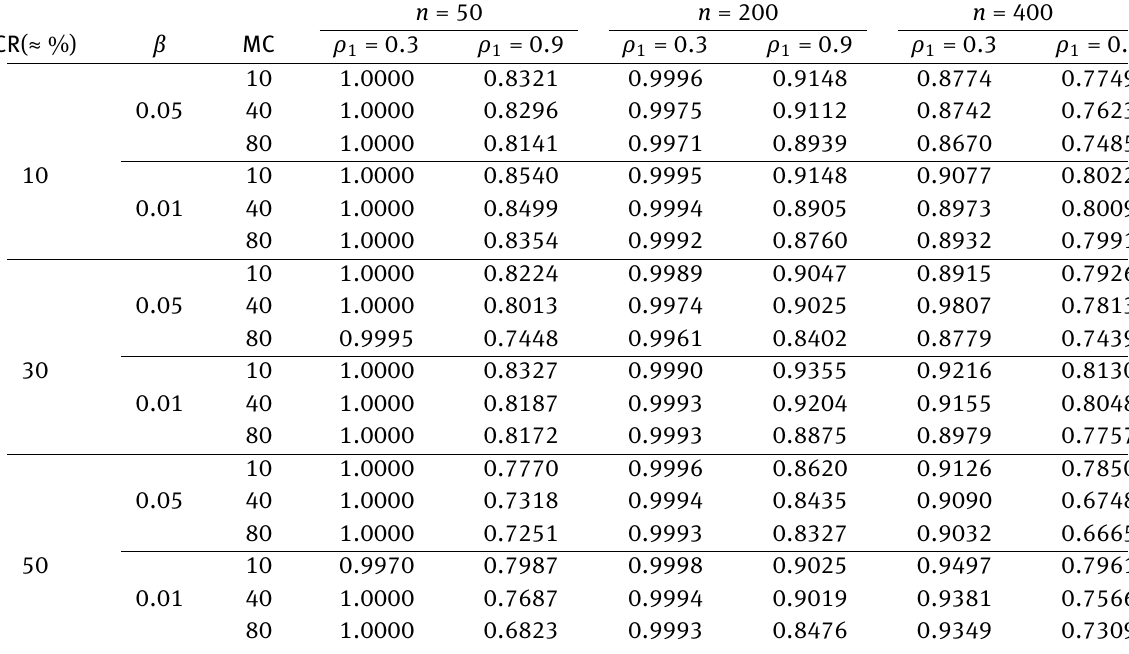
Table 1: Coverage probabilities for 100 replications.